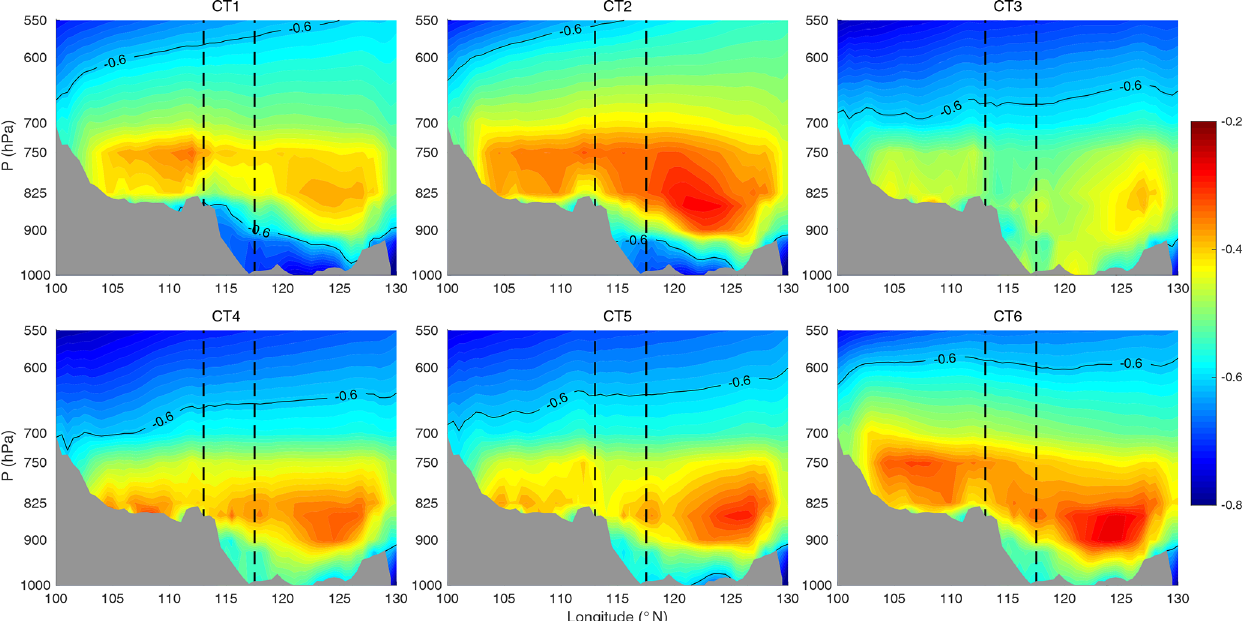
Figure 5. Zonal profile of temperature lapse rate over the BTH region (36–42 ◦ N) (unit: K(100m) − 1 ). The gray region indicates the average altitude over 36–42 ◦ N. The region between the two dashed lines is the horizontal location of the BTH region (113–117.5 ◦ E).